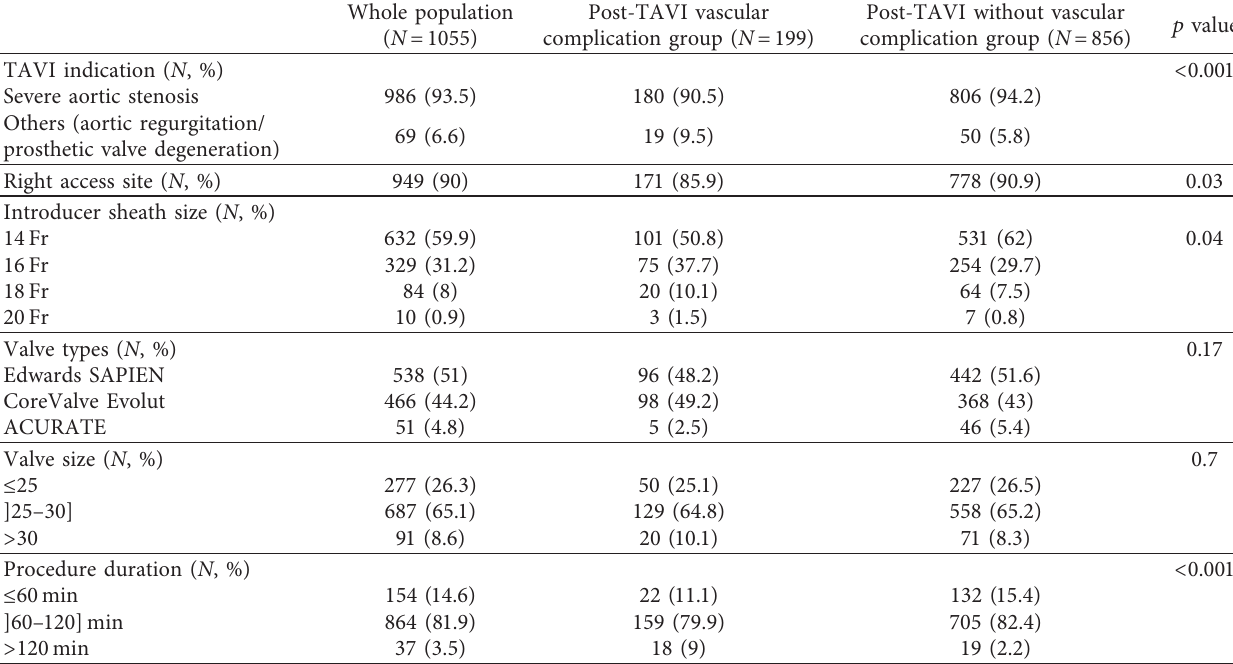
Table 2: Characteristics of transcatheter aortic valve implantation (TAVI) procedures.